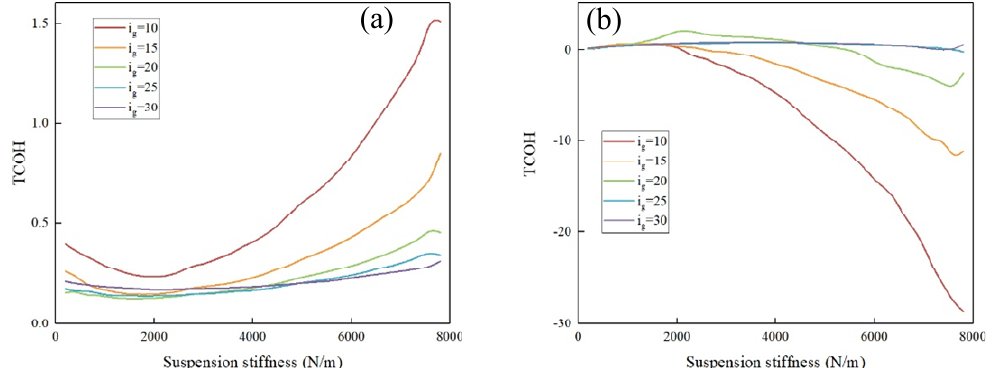
Figure 5. TCOH versus spring sti ff ness under di ff erent gear ratios with walking velocity v = 5.5 km / h and load mass m l = 15 kg: ( a ) Slip model; ( b ) Swing model.